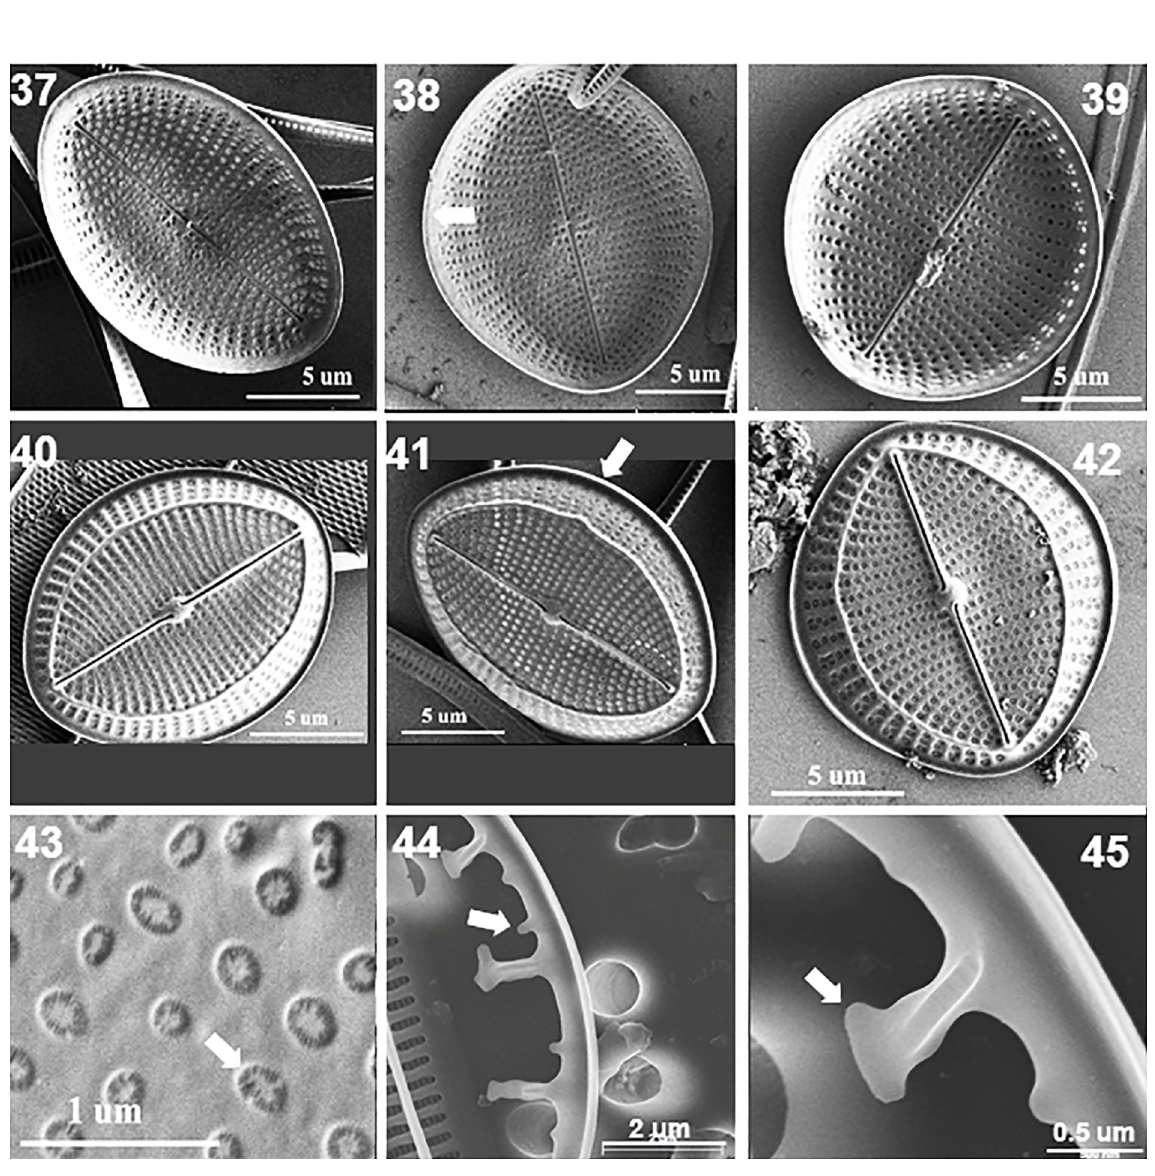
Figs 37–45. SEM images of C. vrangoensis Al-Handal & Riaux-Gob. sp. nov. (BGBM, slide B 40 0043105). 37–39 . External RV side showing uniseriate striae on valve face and bi- to triseriate striae on valve margin, as well as variation in valve outline, arrow on Fig. 36 points to the marginal hyaline area. 40–42 . Internal RV side showing submarginal rim and marginal areolae, arrow on Fig. 41 points to the folded mantle. 43 . Areolae with radiate marginal perforations of the hymens (arrow). 44 . Abvalvar side of the valvocopulae showing shape of fimbriae, with intervalary short fimbriae (arrow). 45 . Enlar- ged part of the abvalvar side of the valvocopula with an oblong papillae